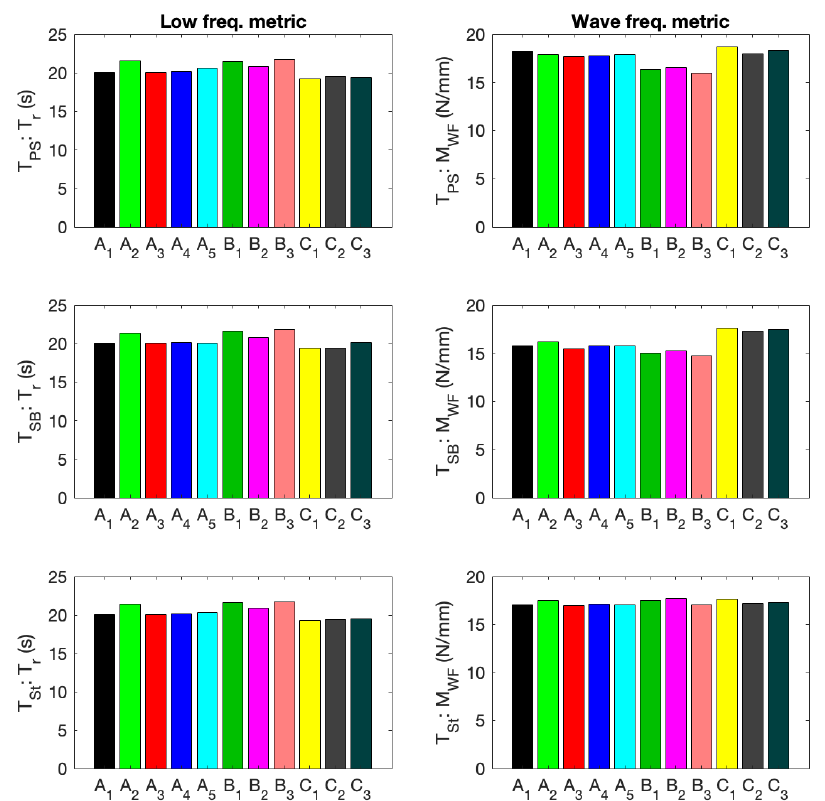
Figure 11. Metrics T r (left column) and M WF (right column) applied to port side ( T PS , top row), starboard side ( T SB , middle row), and stern ( T St , bottom row) mooring line tensions for JONSWAP T p = 1.81 s, H s = 15 cm in basins A, B, and C. The subscripts identify different seeds.